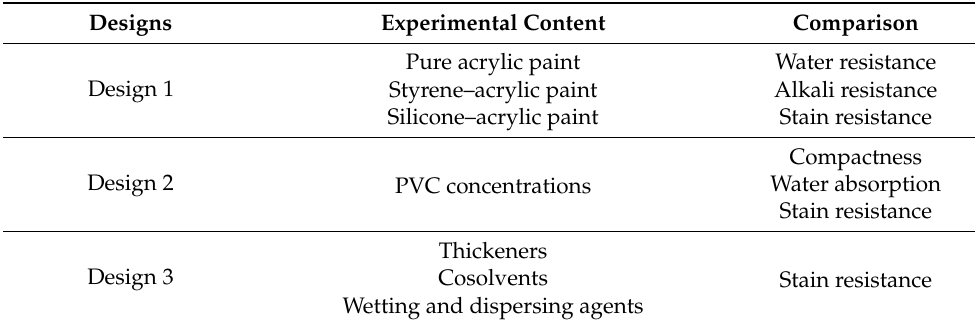
Table 8. Detailed description of Design 1, Design 2 and Design